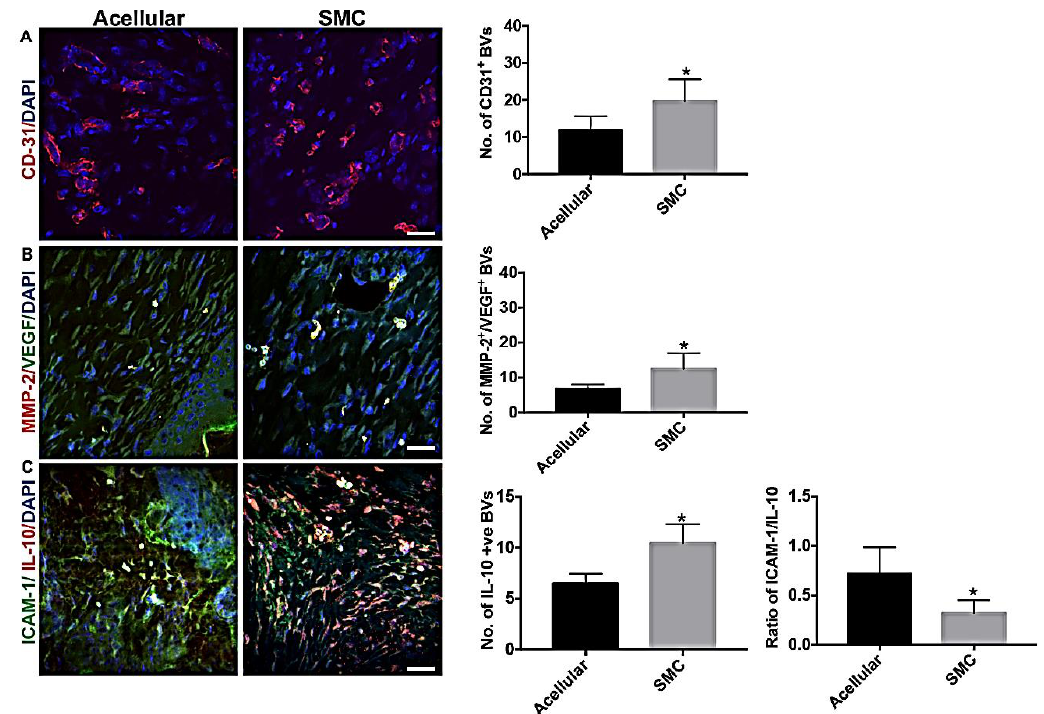
Figure 9. hiPSC-VSMC-mediated angiogenesis and anti-inflammation of blood vessels in vivo. In vivo, angiogenesis and the anti-inflammatory role of hiPSC-VSMCs were characterized. Immunostaining of the wound site, with ( A ) CD31 detecting the blood vessels and the graph showing the number of blood vessels for wounds treated with acellular and hiPSC-VSMC scaffolds, ( n = 7, hiPSC-VSMC vs. Acellular p < 0.02). ( B ) VEGF and MMP-2 showing co-expression of these factors in the blood vessels, and the graph represents the number of blood vessels positive for both VEGF and MMP-2 ( n = 4, hiPSC-VSMC vs. Acellular p < 0.05) and ( C ) IL-10 and ICAM-1 showing the level of these factors in the blood vessels and the graph represent the level of IL-10 ( n = 4, hiPSC-VSMC vs. Acellular p < 0.009) and the ratio of expression of ICAM-1/IL-10 ( n = 4, hiPSC-VSMC vs. Acellular p < 0.05). Dapi was used to stain nuclei. Scale bar represents 50 µm. Statistical analysis was performed using the Student t -test. * denotes statistical significance.